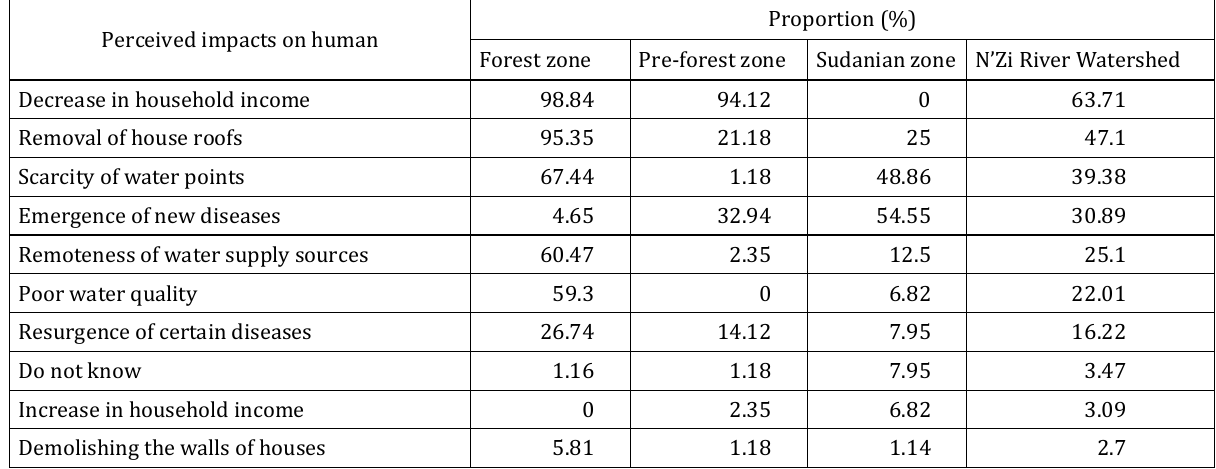
Table 6. Perceived impacts of climate change on people and their settlements Proportion (%) Perceived impacts on human Forest